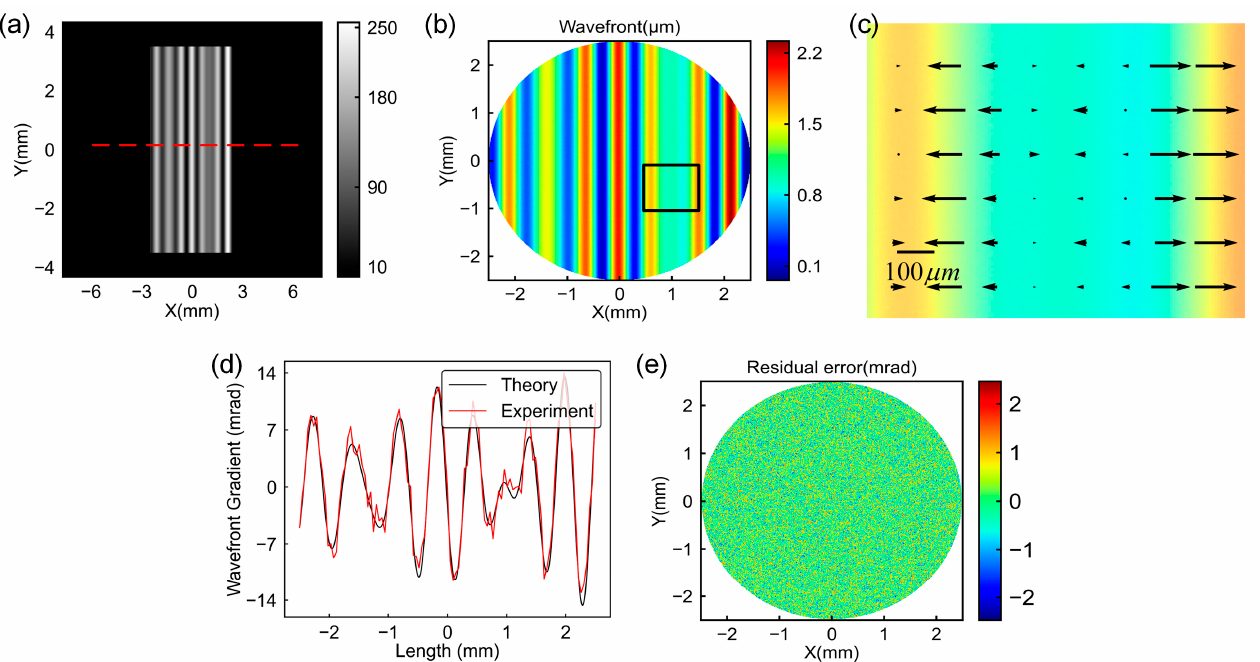
Figure 5. Reconstruction of the complex wavefront. ( a ) Grayscale image loaded onto the SLM. ( b ) Reconstructed wavefront. ( c ) Close-up view of the black rectangle in ( b ), where the arrows represent the wavefront gradients. ( d ) Comparison between measured (red line) and theoretical (black line) wavefront gradient profiles along the red dashed line marked in ( a ). ( e ) Residual error map for measured wavefront gradients.